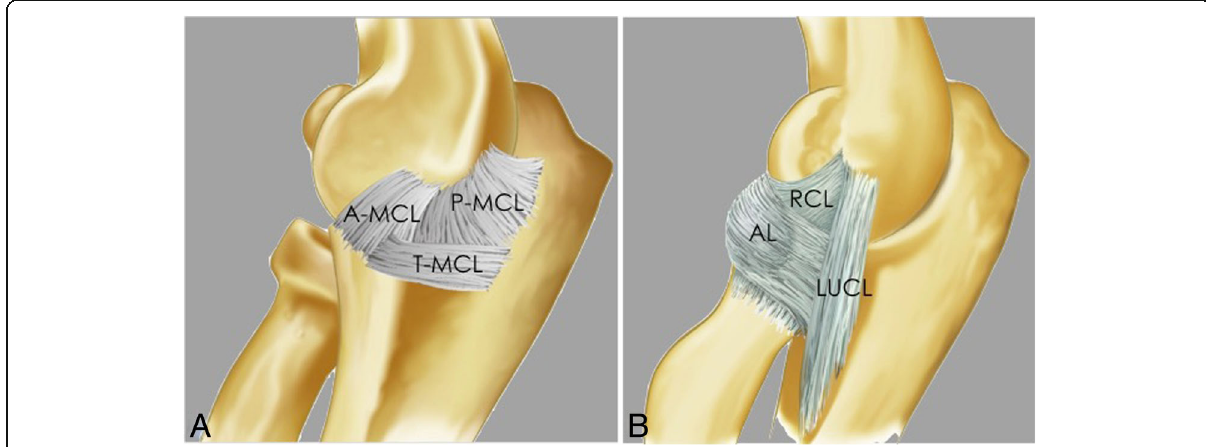
Fig. 4 Elbow illustration. Medial view ( a ) demonstrating the medial collateral ligament complex: anterior bundle of the medial collateral ligament (A-MCL), posterior bundle of the medial collateral ligament (P-MCL), and transverse ligament (T-MCL). Lateral view ( b ) demonstrating the lateral collateral ligament complex: lateral ulnar collateral ligament (LUCL), radial collateral ligament (RCL), and annular ligament